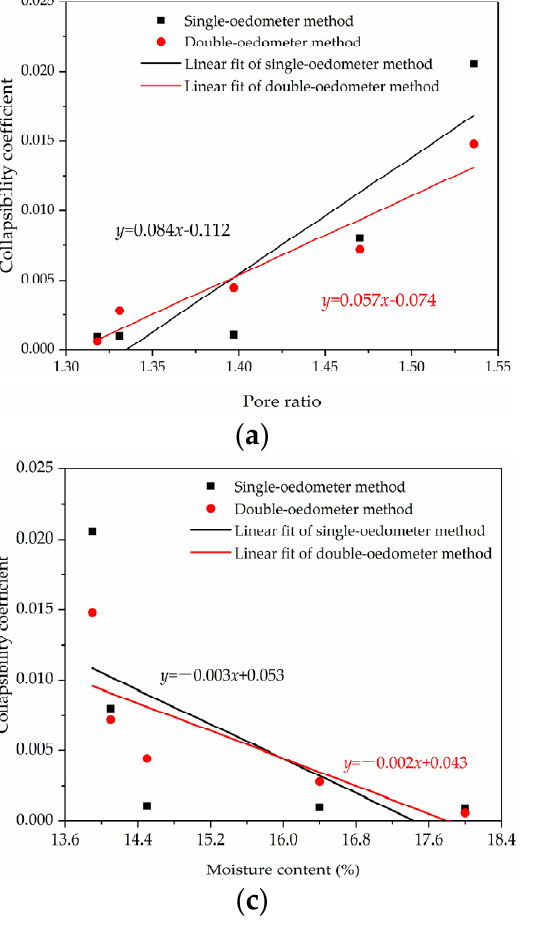
Figure 8. Relation between collapsibility coefficient and physical indexes at 200 kPa. ( a ) Pore ratio; ( b ) dry density; ( c ) moisture content; ( d ) CLS content.